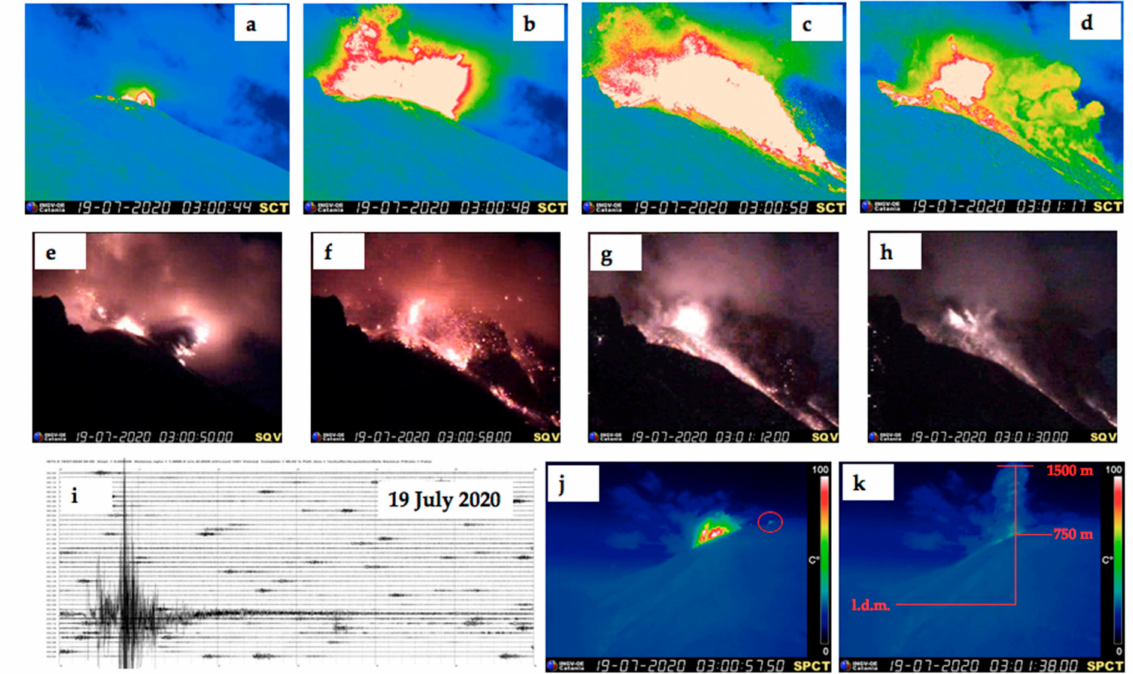
Figure 9. ( a – d ) Thermal images from the SCT camera of the 19 July 2020 explosive event at 03:00:44 ( a ), at 03:00:48 ( b ), at 03:00:58 ( c ), 03:01:17 ( d ), view from NE. Blue is cold, white is hot. ( e – h ) Visual images from the SQV camera recorded at 03:00:50 ( e ), at 03:00:58 ( f ), at 03:01:12 ( g ) and at 03:01:30 ( h ), view from NE. ( i ) Seismic trace of the 19 July 2020 paroxysm as recorded from the IST3 seismic station, Z component. ( j , k ) Thermal images of the 19 July 2020 explosive event from the SPCT camera, view from W, showing ( j ) the fallout of bombs on the Il Pizzo Sopra La Fossa (indicated by the red circle) at 03:00:57.50, and ( k ) the vertical extent of the eruptive plume (750 m above the craters), recorded at 03:01:38. See Figure 1 for station